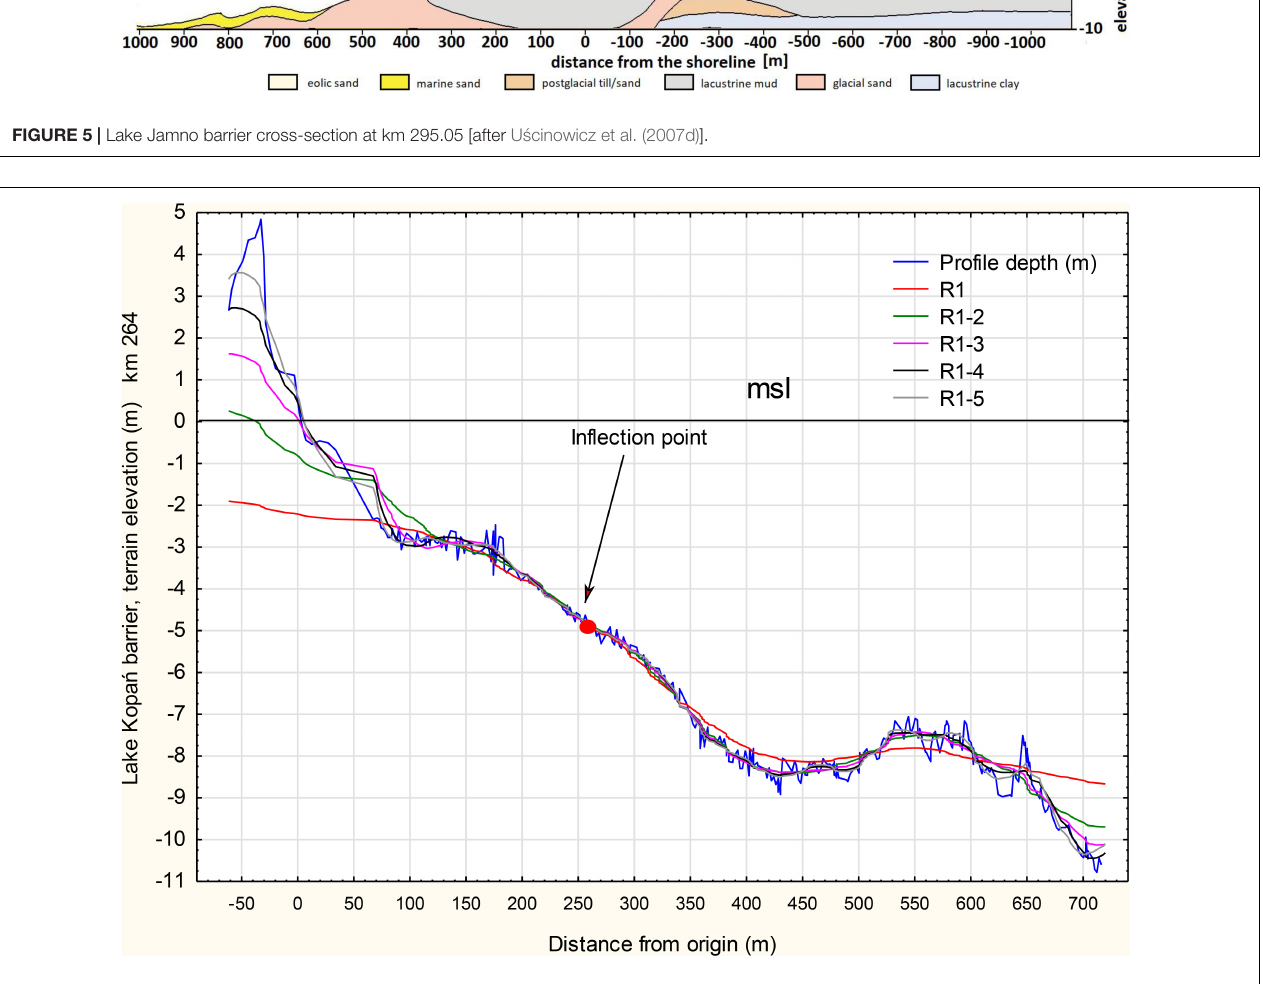
FIGURE 6 | Approximation of nearshore bathymetry with summed monotonic components of SSA decomposition, Lake Kopa´n barrier, km 264.